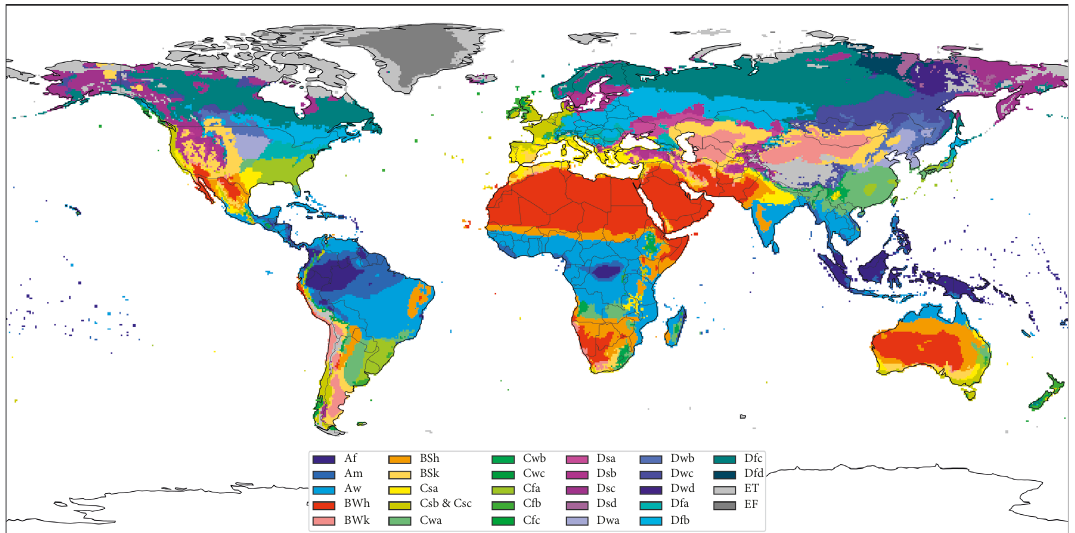
Figure 3: K¨oppen–Geiger classification of the present world climate. The color scheme has been adopted from Peel et al. [20]. 180°